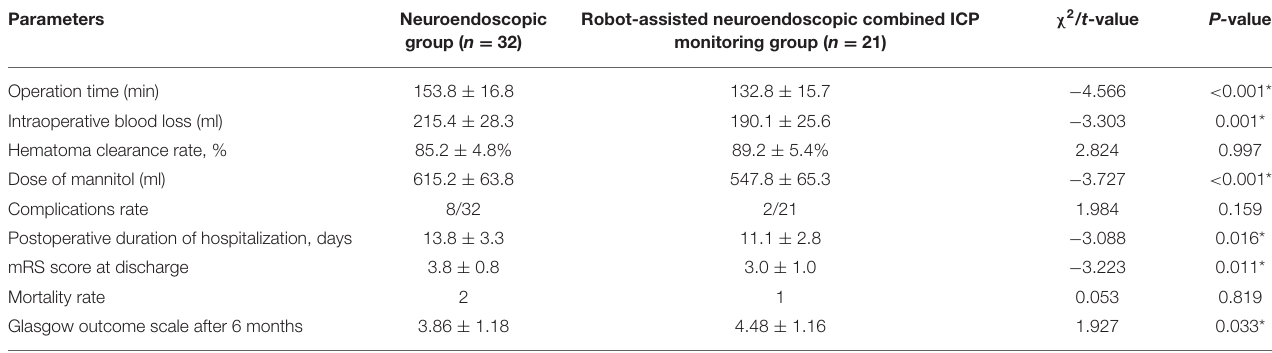
TABLE 2 | Comparison of postoperative data and clinical outcomes in the two groups of patients.